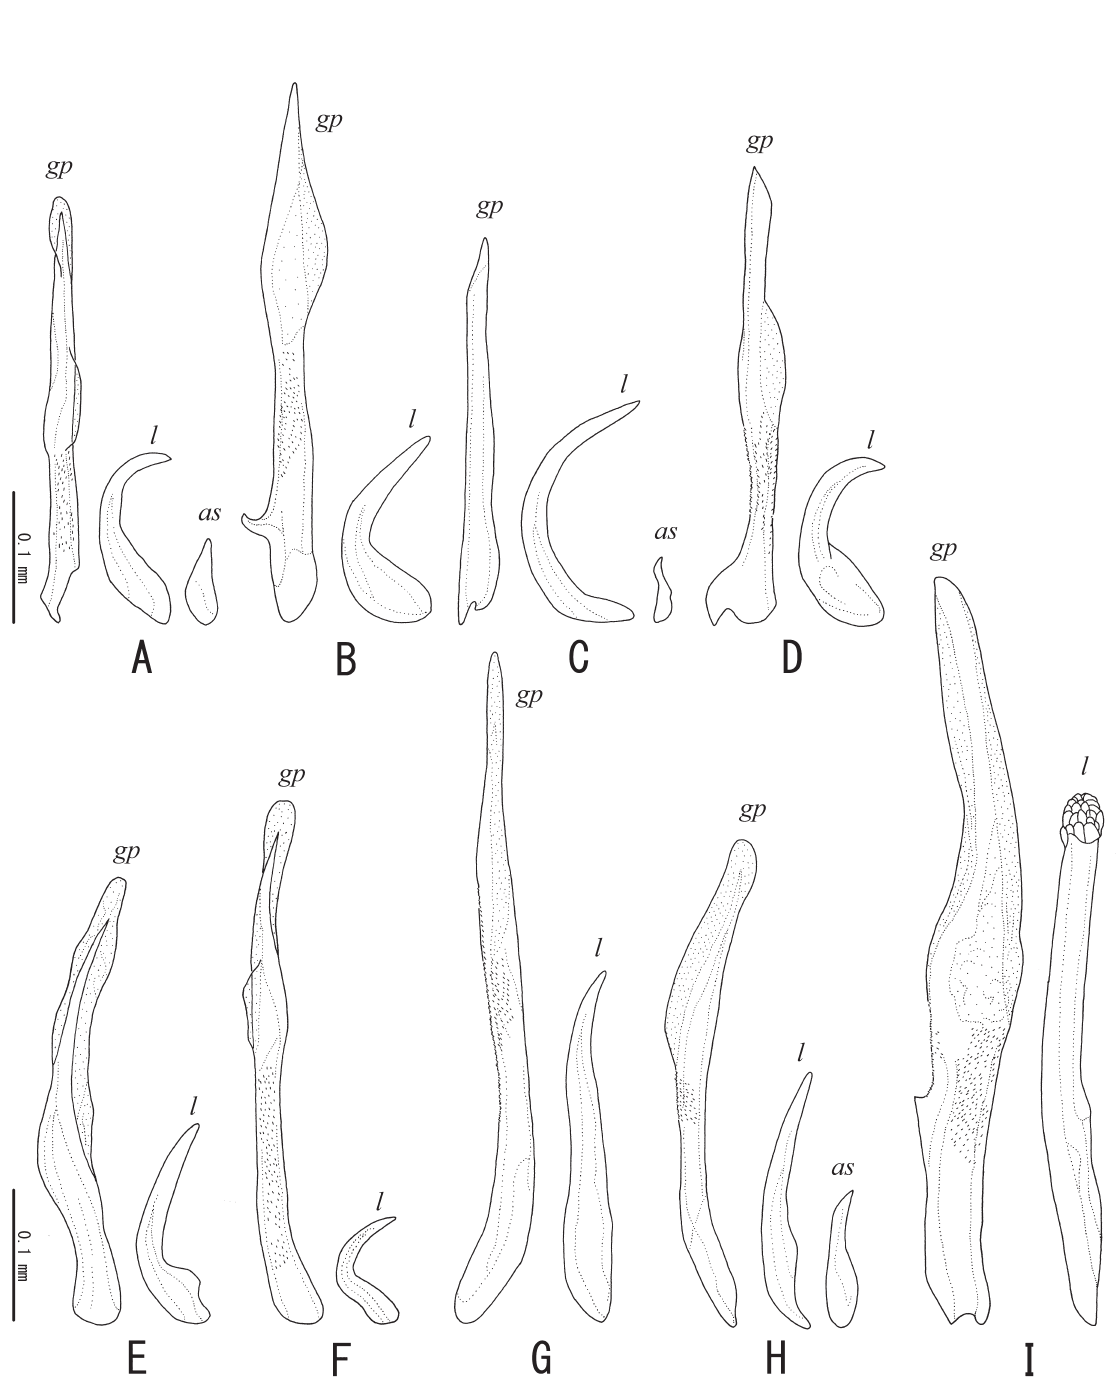
Fig. 4. Endophallic sclerites of Laius spp. A . Laius etsukoae Satô, Yoshitomi & Ohbayashi, 2006 (paratype). B . L. flavicornis (Fabricius, 1801). C . L. keiichii Satô, Yoshitomi & Ohbayashi, 2006 (paratype). D . L. lutaoensis Yoshitomi & Lee, 2010 (paratype). E . L. madli Yoshitomi, 2010 (paratype). F . L. miyamotoi Nakane, 1955. G . L. satoi Yoshitomi, 2008. H . L. taiwanus Yoshitomi & Lee, 2010 (paratype). I . L. pankowi Wittmer,